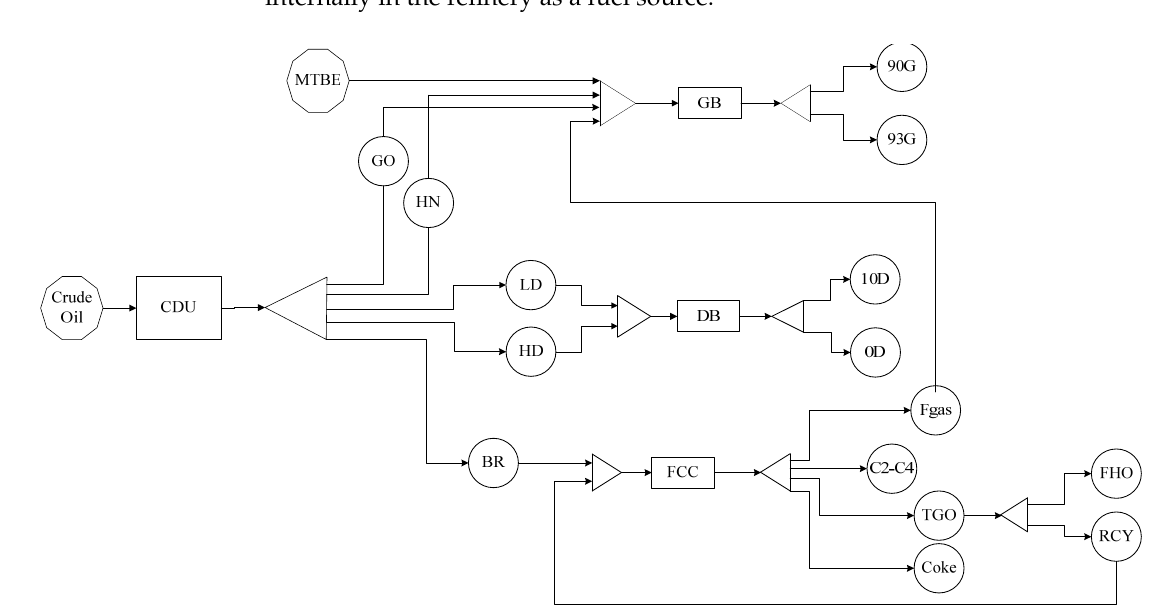
Figure 2. Flowsheet configuration for the refinery planning model (NLP).